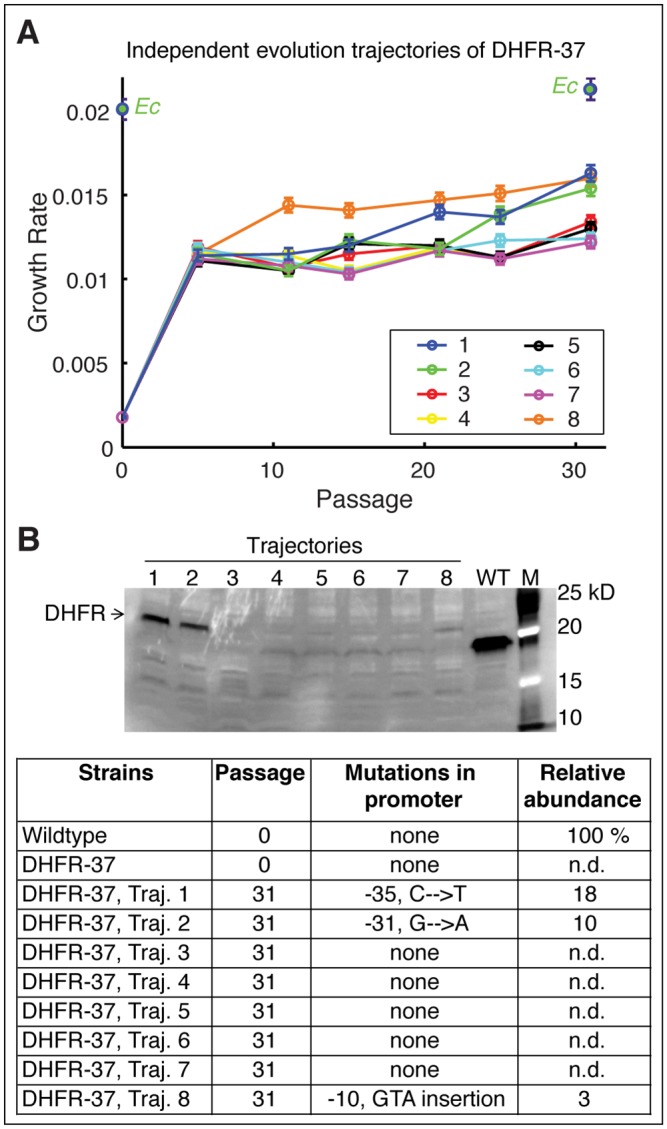
Fine-tuning evolution of orthologous DHFR expression.A) Eight independent evolutionary trajectories of DHFR-37 (from P. ananatis) show an increase in fitness after evolution. Growth rates of each individual trajectories were measured every 5 passages. Three trajectories (1, 2, and 8) become markedly fitter than the rest after 31 passages. Error bars represent standard deviation of 4 independent measurements. B) Soluble abundance of DHFR-37 protein was measured in soluble cell fractions of all eight trajectories after evolution (In the gel, M: Marker). Note the pronounced abundance levels in trajectories 1, 2, and 8. N.d. not detected. Sequencing of folA gene revealed characteristic mutations in the promoter region that explain the increased abundance and improved fitness.